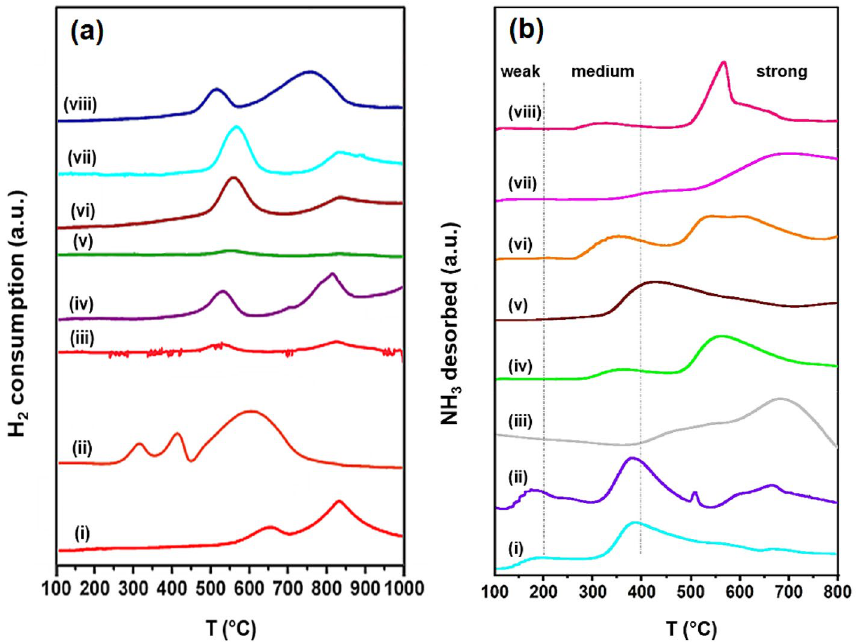
Figure 2. ( a ) H 2 -TPR patterns of (i) CA, (ii) CM, (iii) 15Co/600MA, (iv) 15Co/700MA, (v) 10Co/800MA, (vi) 15Co/800MA, (vii) 20Co/800MA, and (viii) 15Co/900MA catalysts. ( b ) NH 3 -TPD profiles of (i) 800MA, (ii) CM, (iii) CA, (iv) 15Co/700MA, (v) 10Co/800MA, (vi) 15Co/800MA, (vii) 20Co/800MA, and (viii) 15Co/900MA